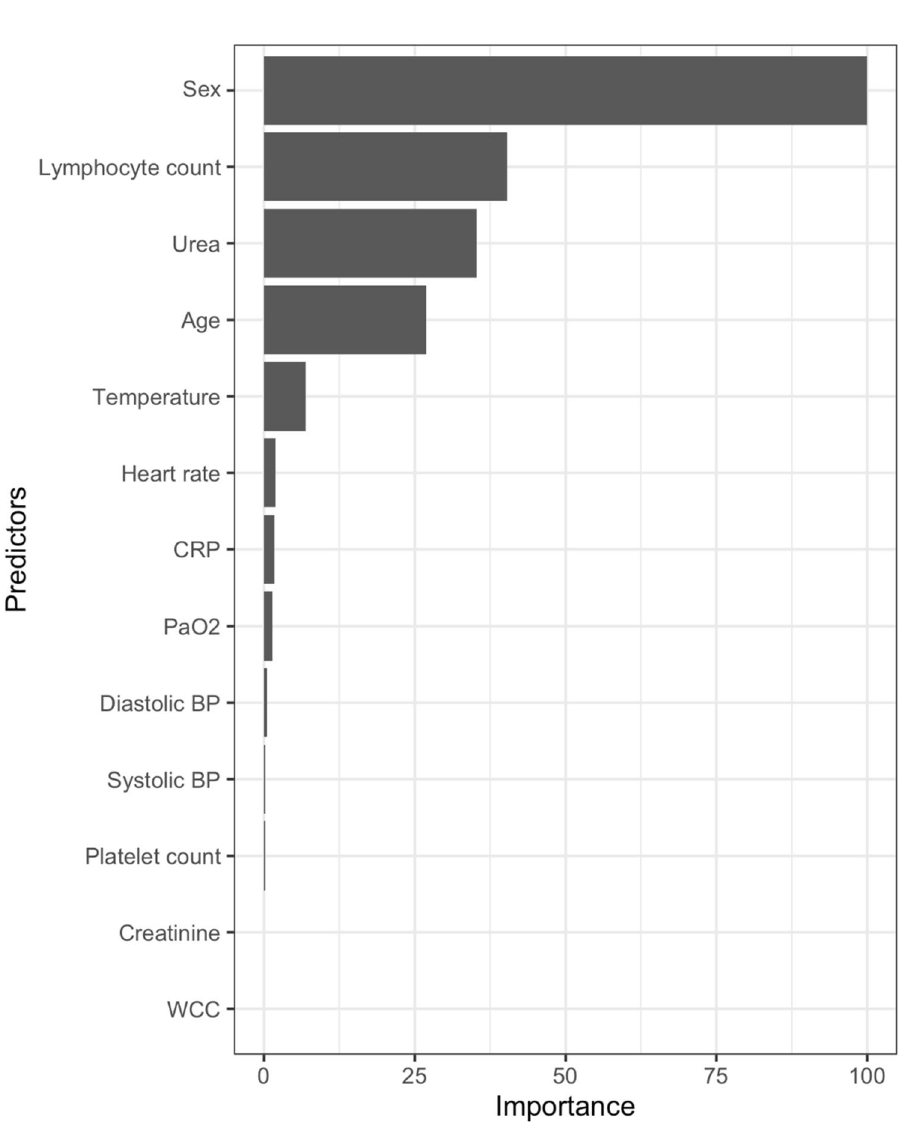
Figure 3. GLMNET (Lasso/Ridge) Variable importance plot with predictors having less than 40% missing values in the database. All patients are confirmed positive for SARS-CoV-2 by RT-PCR. The plot shows the importance of predictors in building the development predictive model. BP, blood pressure; PaO 2 , partial pressure of O 2 ; WCC, white cell count; CRP, C-reactive